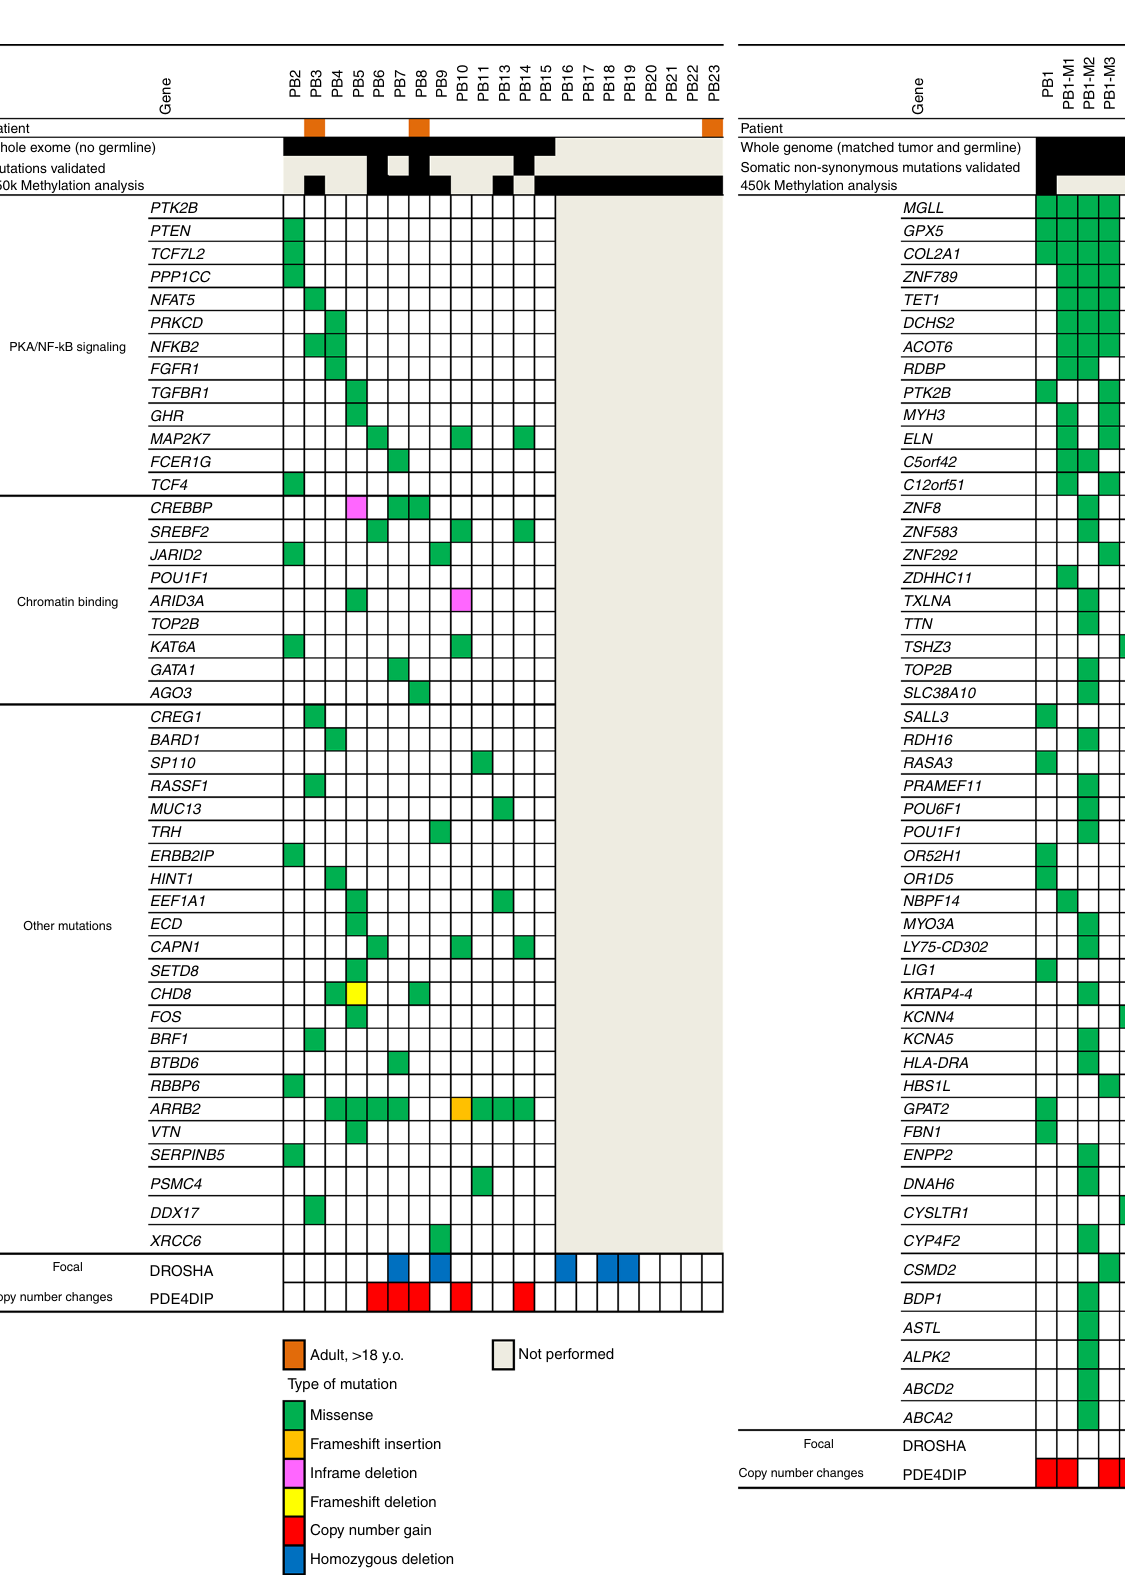
Fig. 2 Genomic landscape of pineoblastoma. Whole-exome sequencing was performed in 13 tumors with no matching germline (exome samples, left). Whole-genome sequencing (genome samples, right) was performed in fi ve tumors, two primary (PB1 and PB12) with matched peripheral blood DNA and three metastasis from PB1 (M1, M2, M3). Speci fi c genes are shown that bear nonsynonymous mutations. In exome samples only mutations enriched in pathway analysis via Ingenuity Pathway Analysis (IPA) software are included. In genome samples, only somatic nonsynonymous mutations are presented. Suf fi cient material was available to con fi rm mutations in eight tumors (mutations validated). See also Supplementary Table 1 for mutation